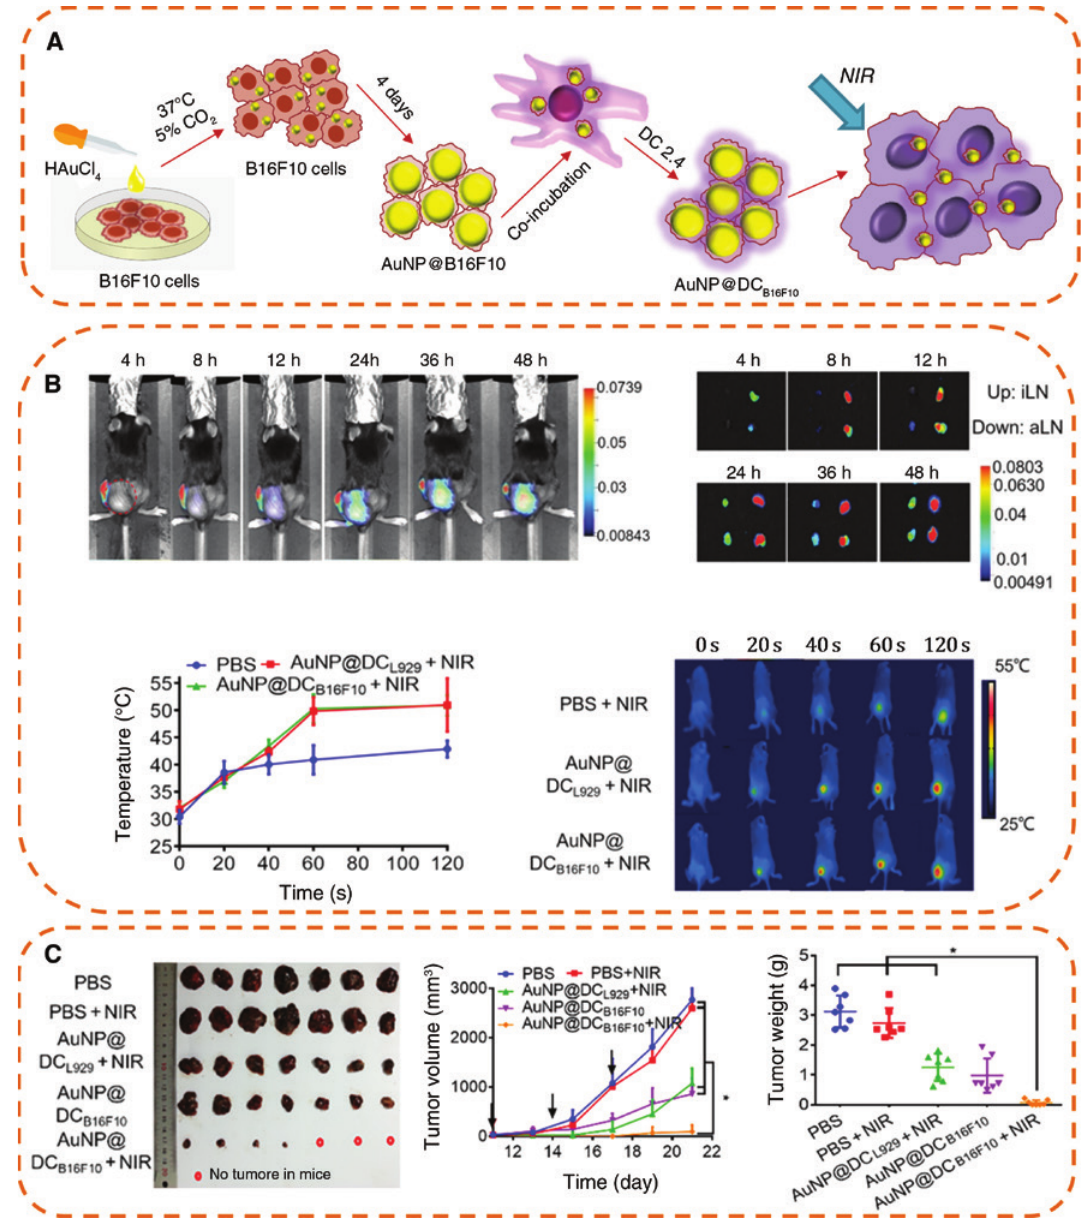
Figure 7: In vivo characterisation and antitumour effect of immunological Au NPs combined PTT and tumour antigen-based immunotherapy. (A) Schematic diagram of PTT using Au NPs. (B) In vivo distribution of Au NPs labeled with fluorescent marker in tumour-bearing mice at different time points. IR thermal images with corresponding temperature profiles. (C) The photographs of tumours from the sacrificed mice at the 21st day. Tumour growth curves after different treatments with and without laser irradiation of 2.0 W cm −2 . Tumour weight of the sacrificed mice at the 21st day. Adapted with permission from [108]. Copyright 2019 American Chemical